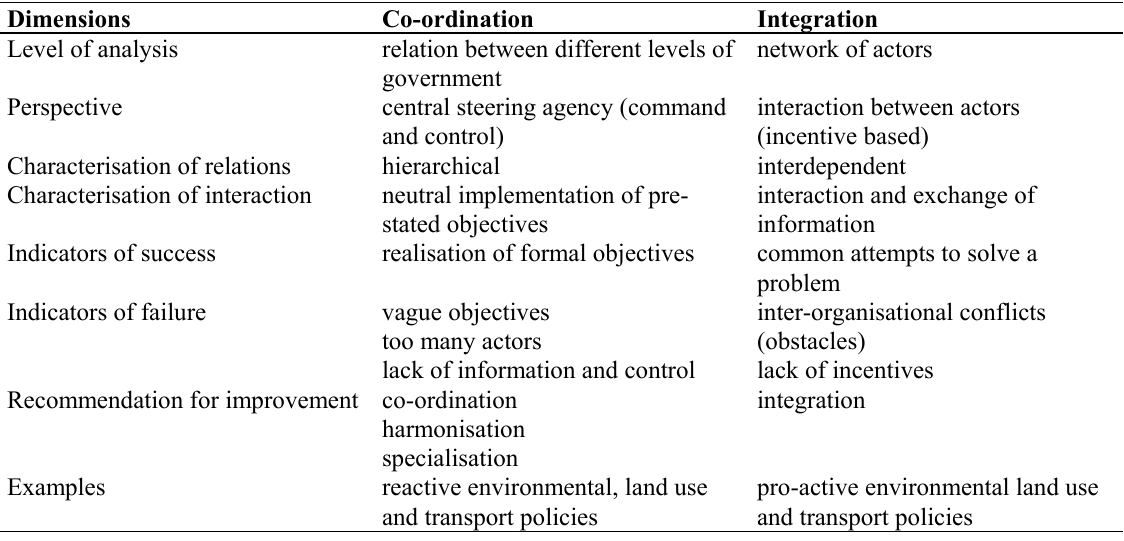
Table 3. Steering paradigms of government